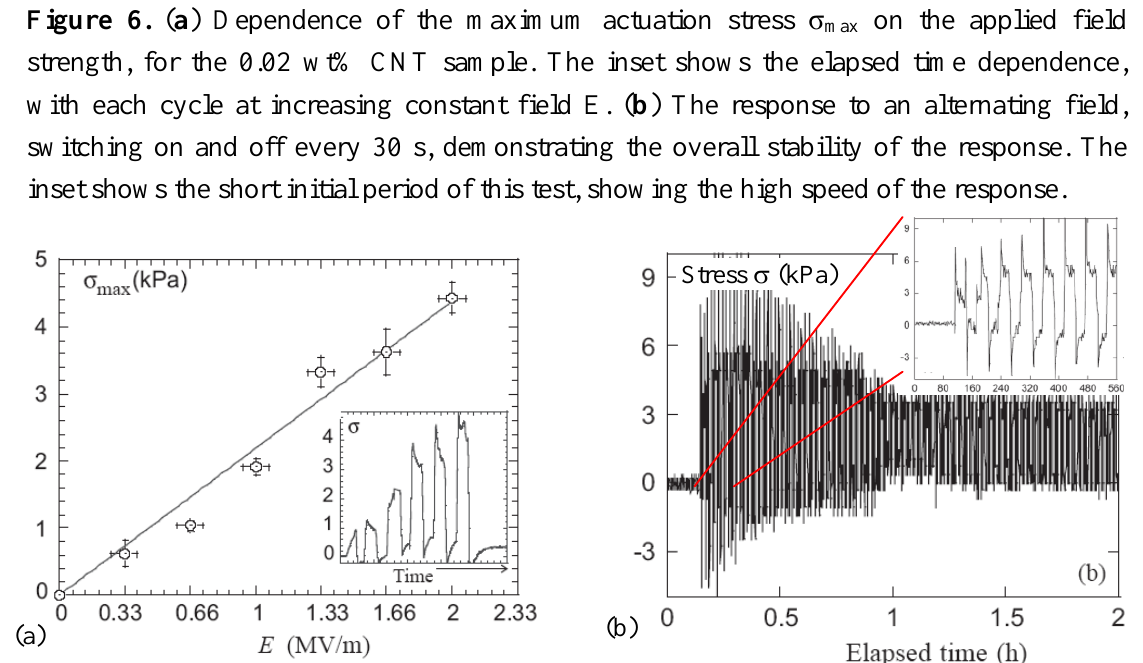
on the applied field max